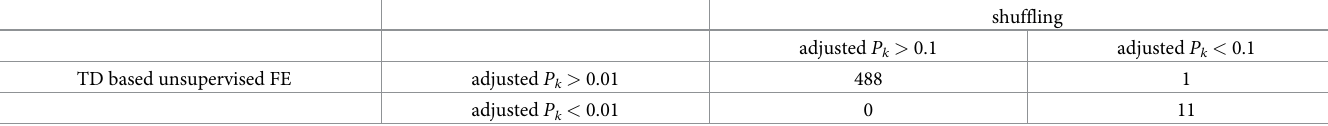
Table 6. Confusion matrix of selected miRNAs between TD-based unsupervised FE and shuffling in the first data set. P -value computed by Fisher’s exact test is 1.28 × 10 − 21 .